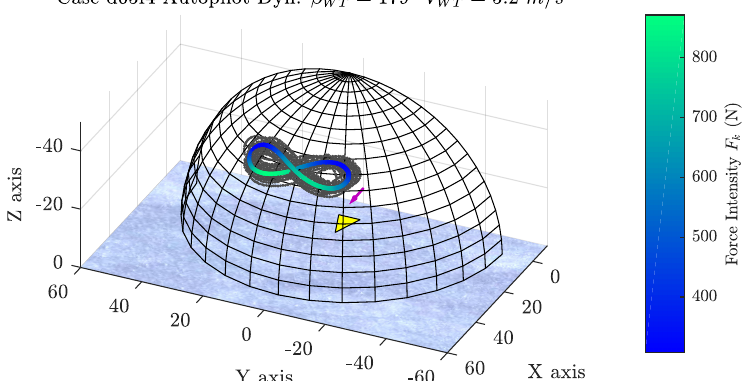
Figure 11. Kite trajectory during a downwind run in black. The yellow triangle denotes the kiteboat position, and the magenta arrows give the orientation of the true wind. The trajectory processed by the phase-averaging method is colored in order to show the kite force with respect to its position.